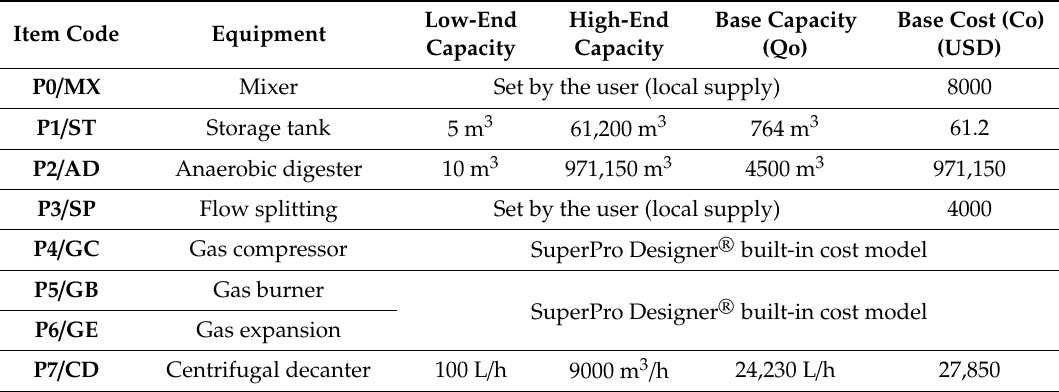
Table 3. Equipment cost